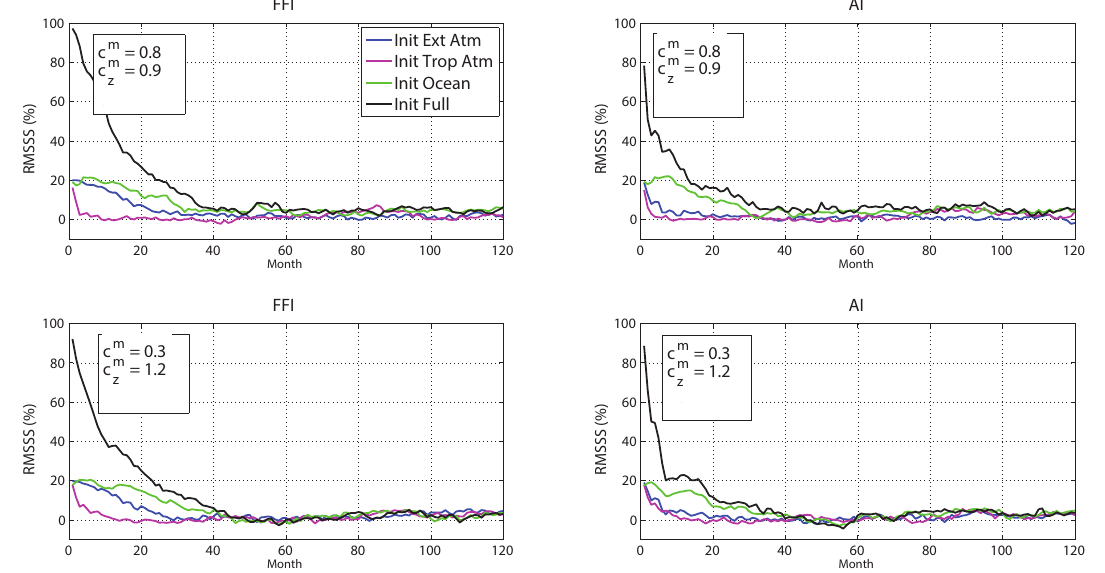
Fig. 3. RMSSS as a function of the forecast lead time for FFI (left panels) and AI (right panels). Top/bottom panels refer to the case c m = 0 . 8, c m z = 0 . 9 /c m = 0 . 3, c m z = 1 . 2, respectively. Different colors represent the case of the initialization of the full system (black), ocean (green), tropical atmosphere (purple) and extratropical atmosphere